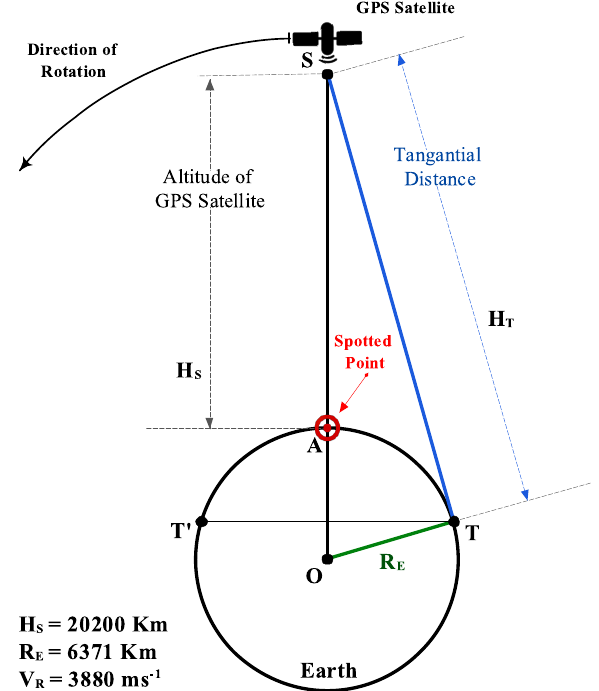
Figure. 1. The Snapshot of the selected scenario. Without lose of generality, the GPS has selected as navigational constellation and V R is the orbital speed of satellite.